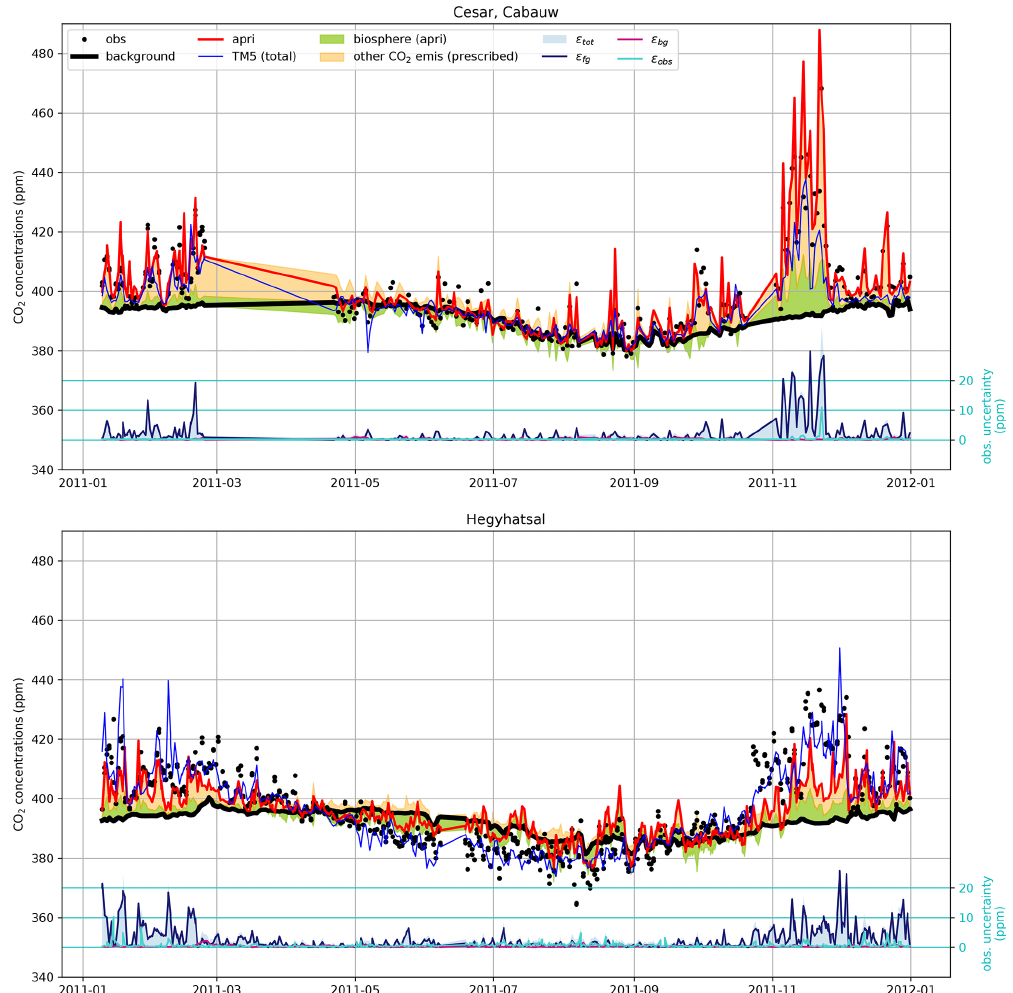
Figure 3. Decomposition of the modeled mixing ratio and of the observation uncertainties at two sites (Cabauw, the Netherlands, and Hegy- hatsal, Hungary). The “TM5 total” line is the concentration computed in the coarse-resolution TM5 inversion from which the background (thick black line) is extracted. The LUMIA prior concentration is shown in red, and the green and orange shaded areas respectively show the contribution of the prior biosphere flux and of the other CO 2 fluxes to the difference between that prior and the background. The lower series of lines in each plot (with y axis on the right) show the total observation uncertainty (blue shaded area) and the contributions of the foreground, background and observational